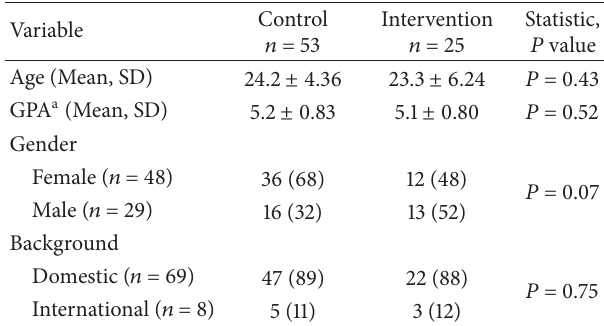
Table 3: Demographic data of the participants (obtained in phase